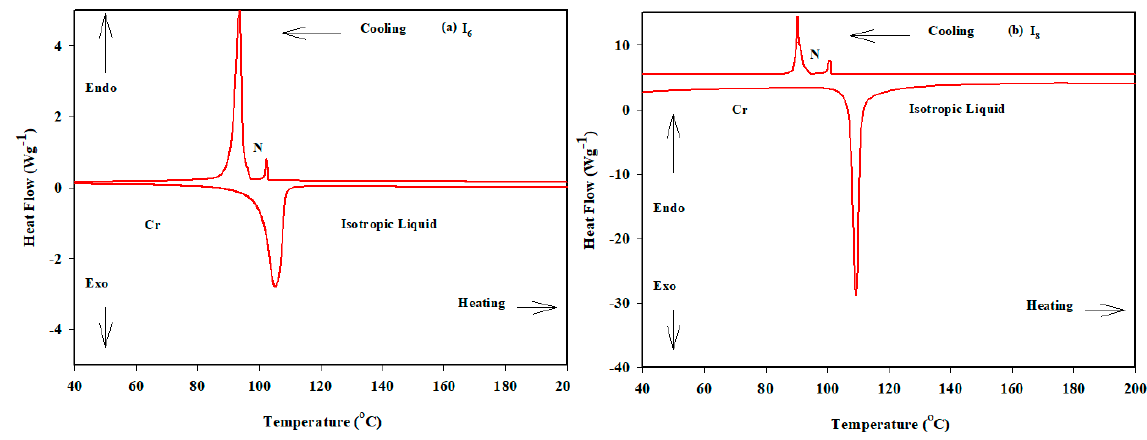
Figure 1. DSC thermograms of ( a ) I 6 and ( b ) I 8 observed from second heating/cooling at a rate of ±10 ° C.